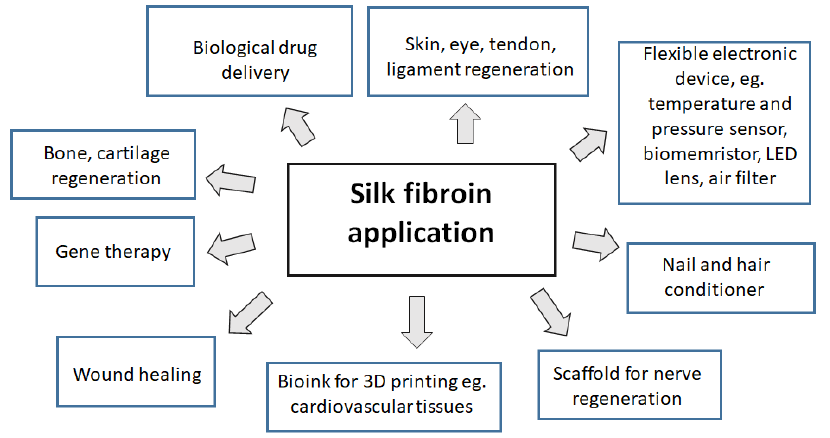
Figure 4. The most typical applications of silk fibroin.